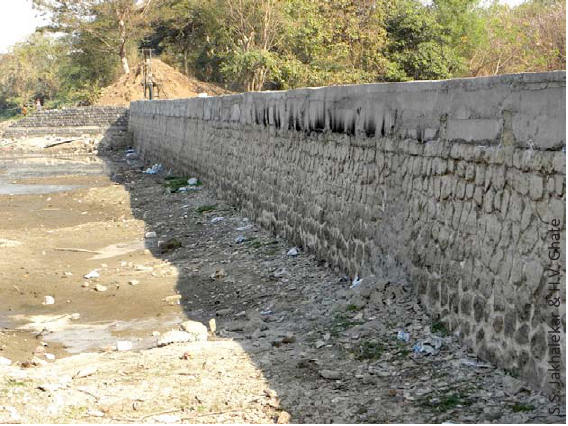
Image 3. Rocky bund-wall of Pashan reservoir,